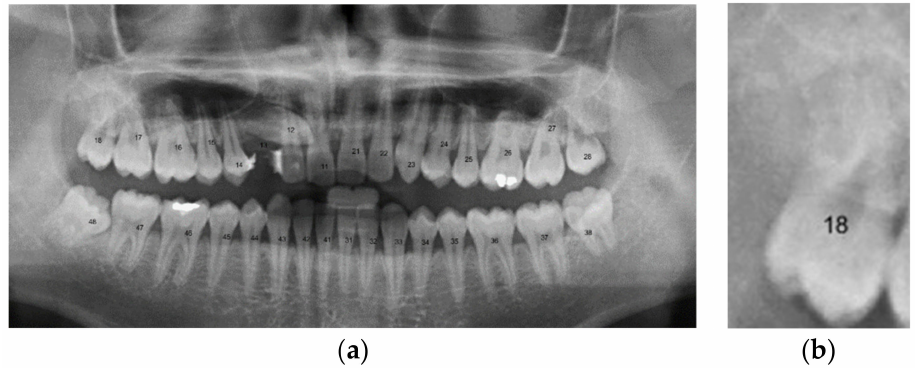
Figure 27. The marks and positions. ( a ) On X-rays, with ( b ) mark and position results.